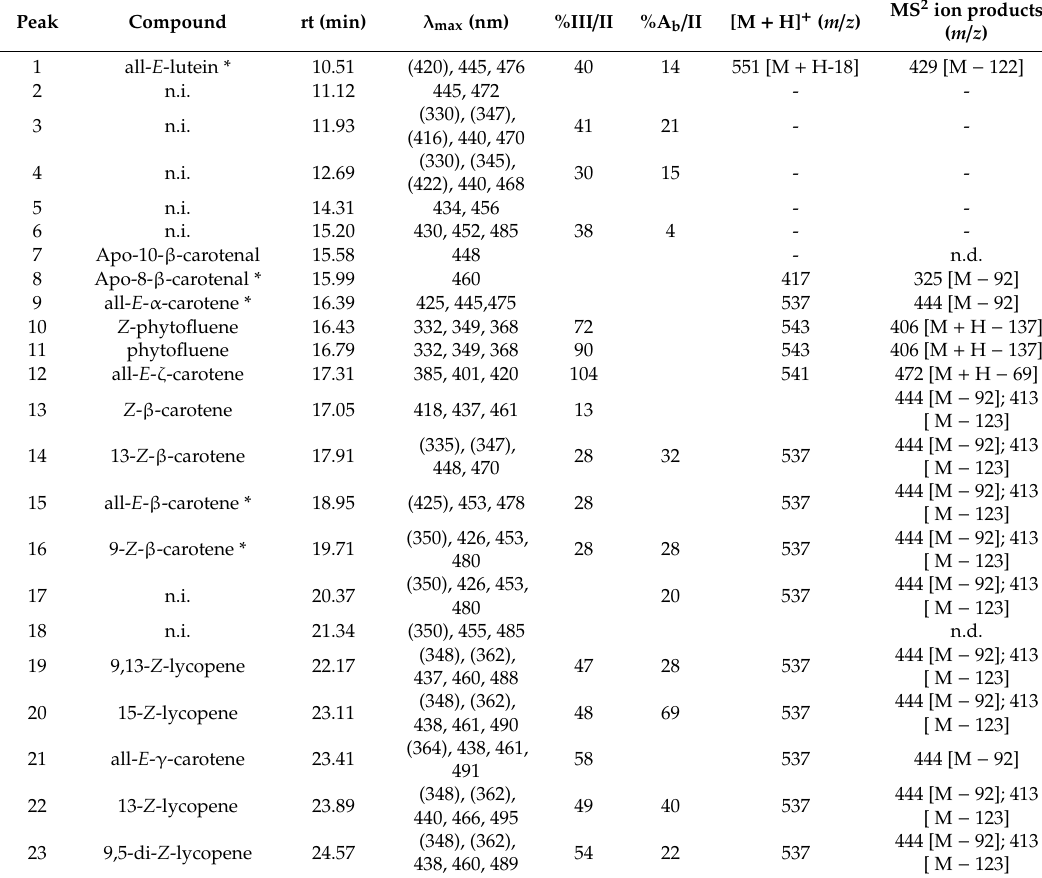
Table 2. Carotenoid identification in the sofrito oil